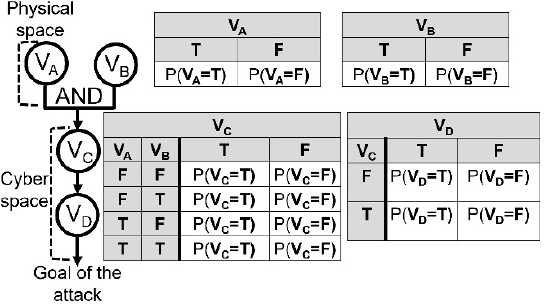
Figure 5. Bayesian network attack graph and conditional probability table structure of Node 6 .